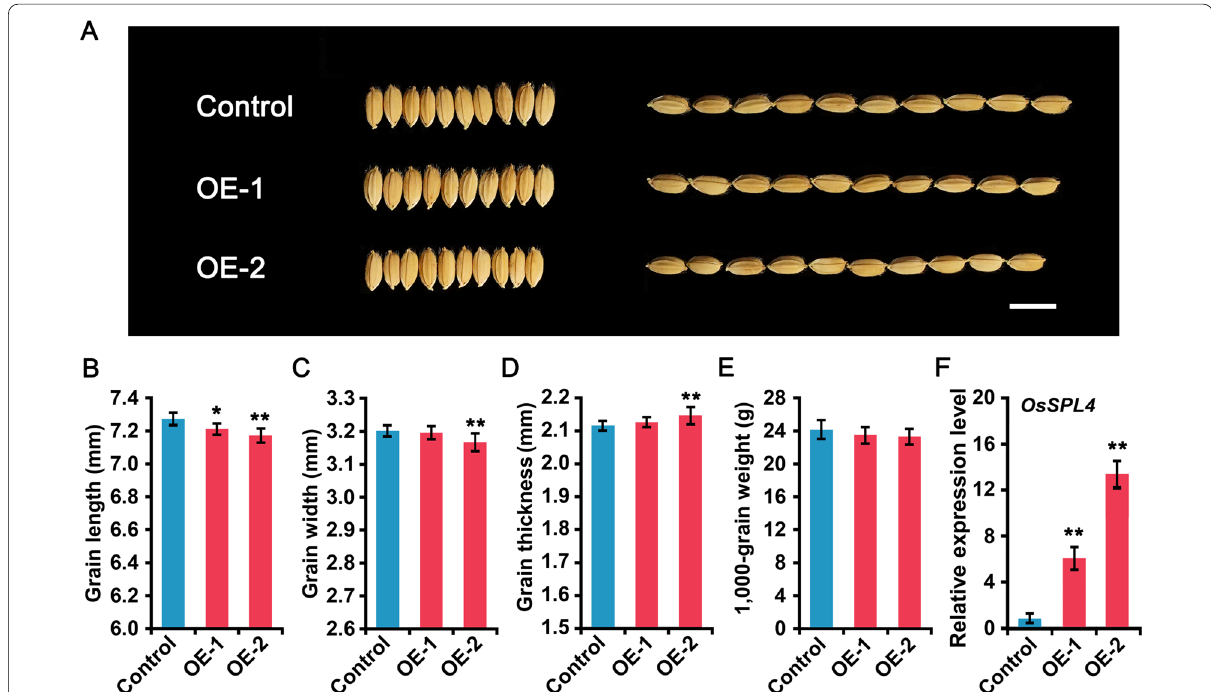
Fig. 3 Overexpression of OsSPL4 decreases rice grain size and weight. A Grain comparisons of the control and OsSPL4 overexpression plants, scale bar 10 mm. B – E Comparisons of the grain size and expression patterns in the control and OsSPL4 overexpression plants. B Grain length. C Grain = width. D Grain thickness. E 1000-grain weight. F The expression levels of OsSPL4 . Significant difference was determined by Student’s t test, * P < 0.05, ** P <